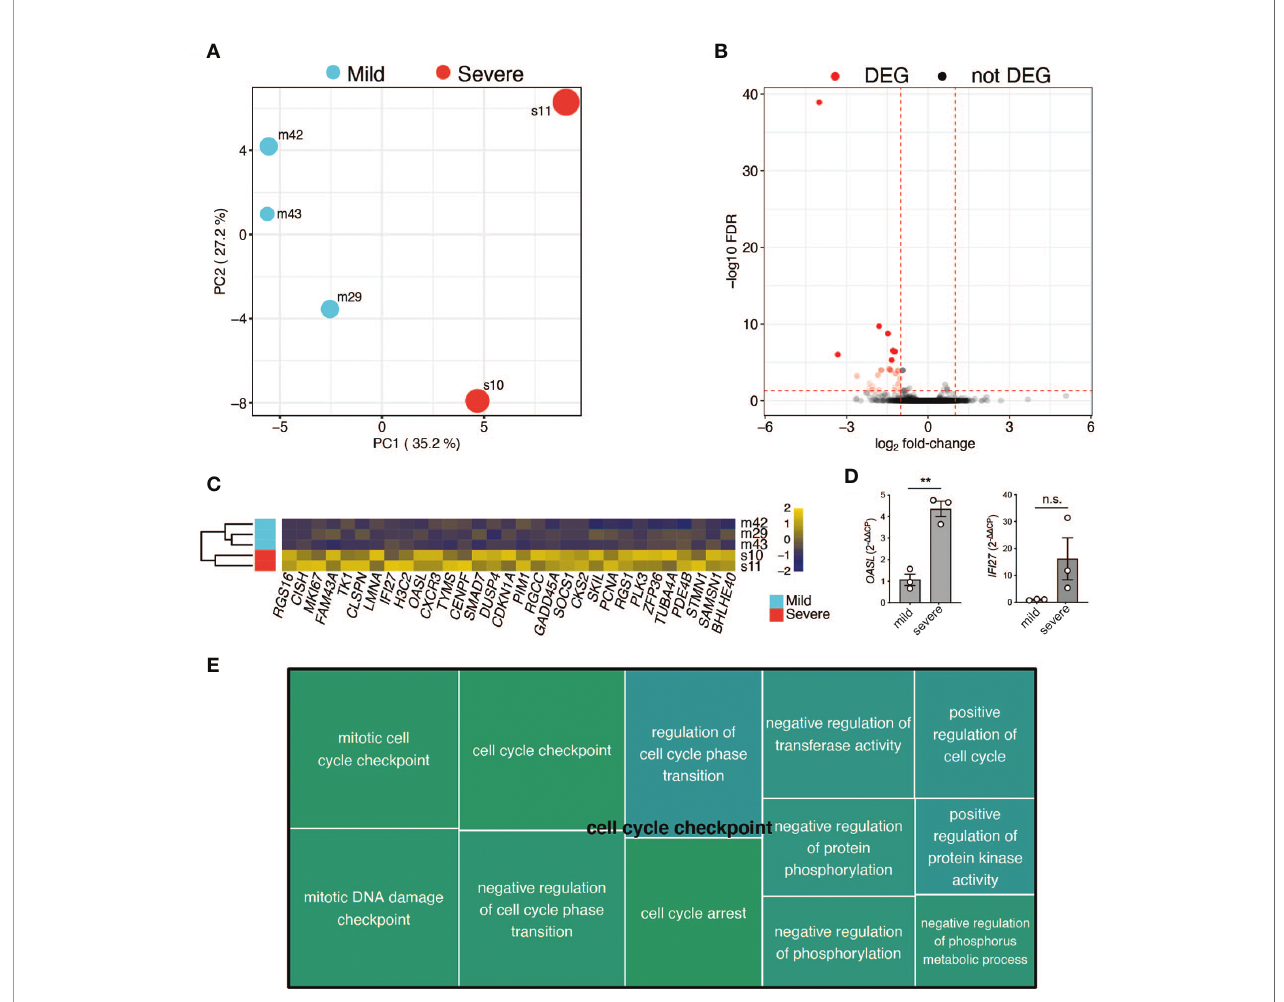
FIGURE 6 | RNA-Seq analysis of selected patients. (A) Principal component analysis based on the expression values of 16,282 protein-coding genes. First (PC1) and second (PC2) principal components. The size of the dots represents the severity score of the corresponding sample. PC1 explains ~40% of the variance and separates patients with a mild COVID-19 course from the ones with a severe COVID-19 course. (B) Volcano plot showing the adjusted p-values and fold-changes in gene expression levels of patients with a mild COVID-19 course relative to patients with a severe COVID-19 course. DEGs are highlighted in red. (C) Heatmap showing the row-scaled regularized log transformed counts of the DEGs. Each column represents a gene and each row, a patient. The genes are ordered according to their fold-change, with the most down-regulated gene in mildly affected patients on the left. (D) qRT-PCR of CD3 + T cells from three independent patients within the mildly versus severely affected COVID-19 patient groups (TP1). Unpaired student ’ s t test. **P < 0.01; n.s., not signi fi cant. (E) Tree map of biological process gene ontology (GO) terms enriched among the DEGs. Only GO terms with at least 5 impacted genes are displayed. Each GO term is represented by a rectangle with a size corresponding to its p-value. Related GO terms are visualized with similar